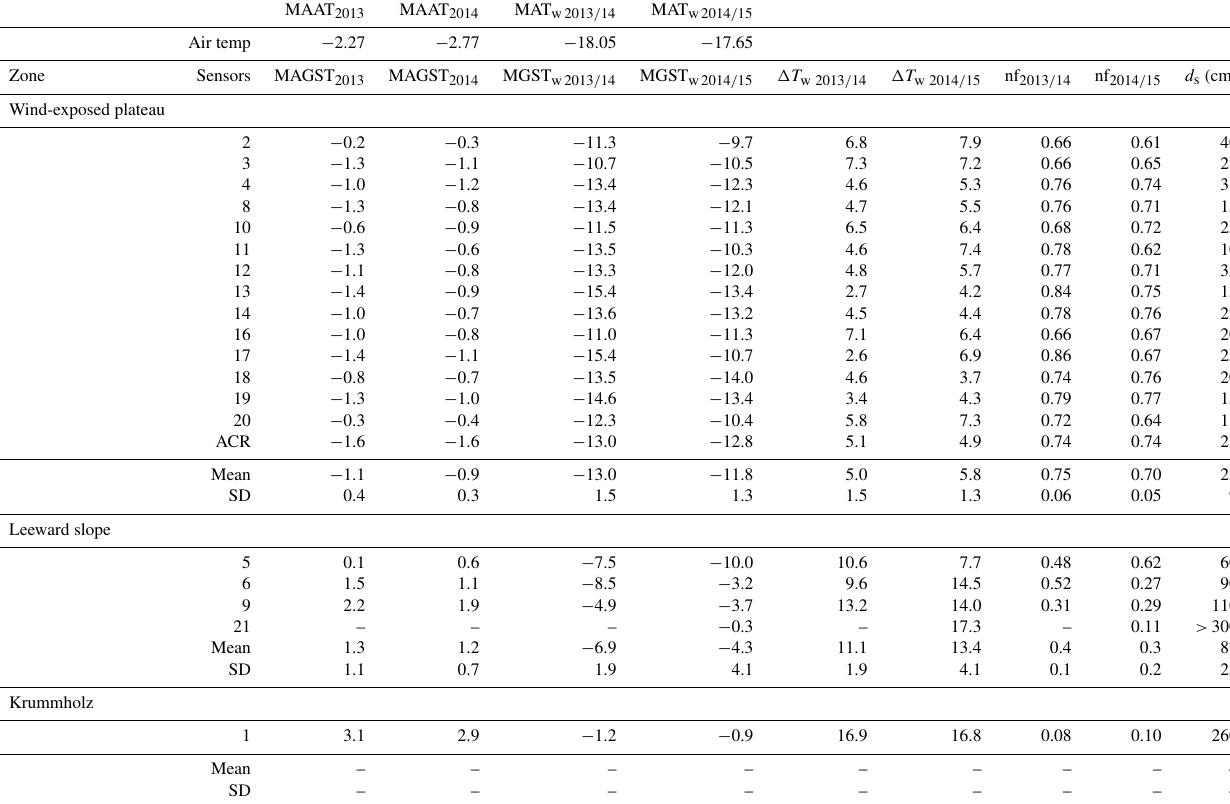
Table A1. Summary of the variable ground surface thermal conditions for each zone. The mean annual air temperature (MAAT) and mean annual ground surface temperature (MAGST) for 2013 and 2014 and the mean winter air temperature (MAT w ) and mean winter ground surface temperature (MGST w ) for both winters 2013–2014 and 2014–2015 have been calculated. From MGST w and MAT w , the average surface thermal offset ( (cid:49)T ) of both winters has been calculated. The freezing n factor (nf) was calculated for the freezing season 2013–2014 and 2014–2015 and thawing n factor (nt) was calculated for thawing season 2013 and 2014. The snow depth ( d s ) was measured in April